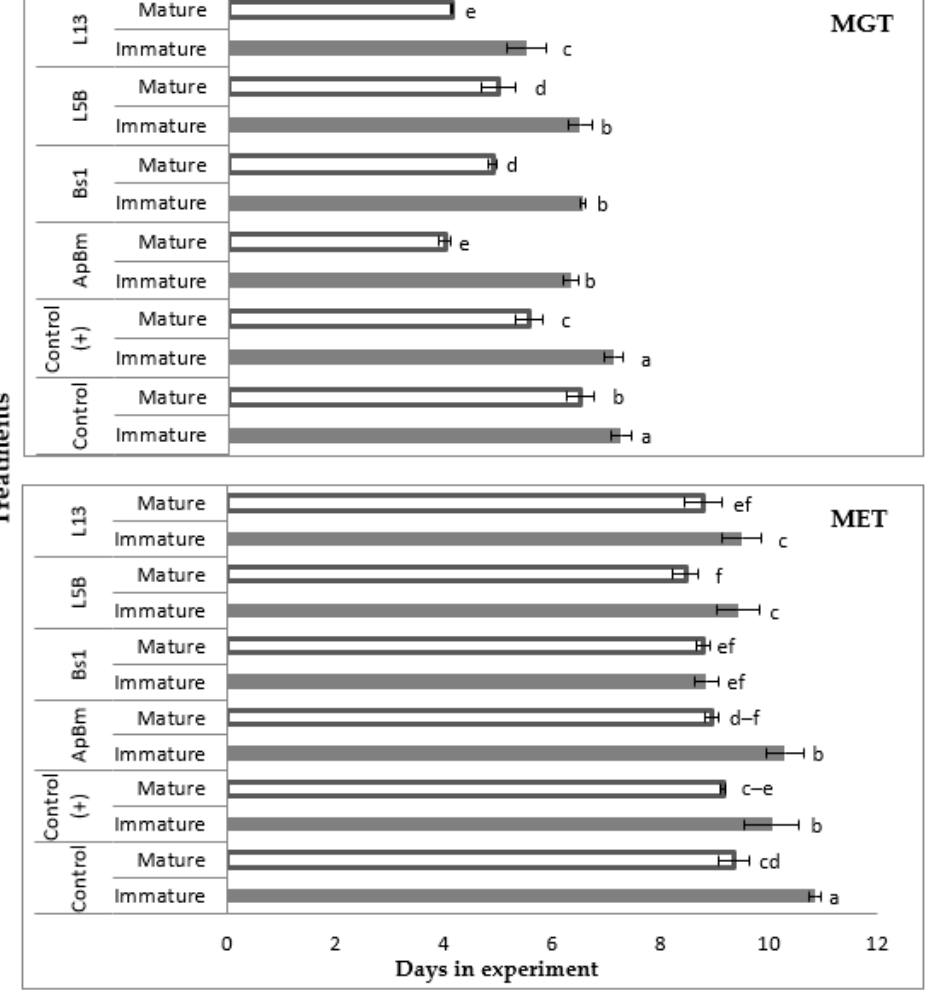
Figure 4. Mean germination (MGT) and seedling emergence (MET) times of bio-primed and control pepper seeds. Data Scheme 0. for the same criterion. Table 3. Advantage table for the endophytic bacteria strains against control groups for pepper seeds.